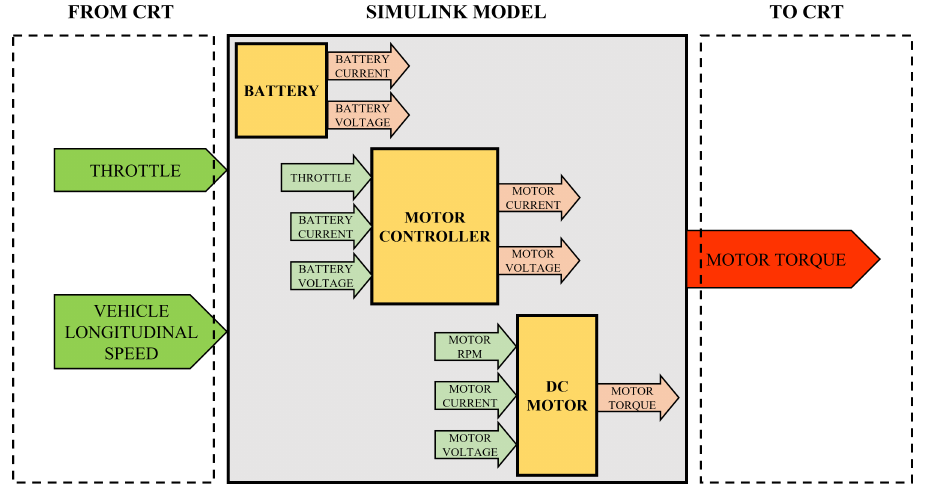
Figure 3. Simulink powertrain model. Green entities refer to the model inputs; the red entity is the